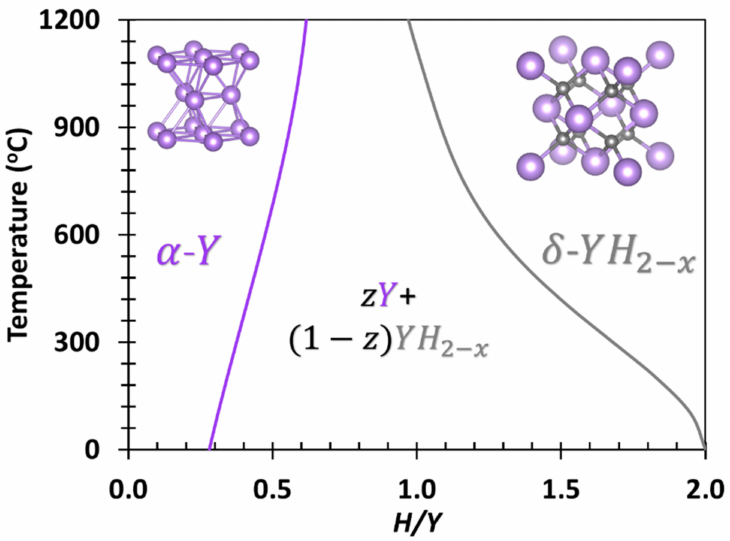
Figure 1. Phase diagram for the Y - H system (from [19,21] based on [14]). Crystal structures of α - Y and δ - YH 2 shown in respective phases. Large purple spheres are yttrium atoms, whereas small grey spheres are hydrogen